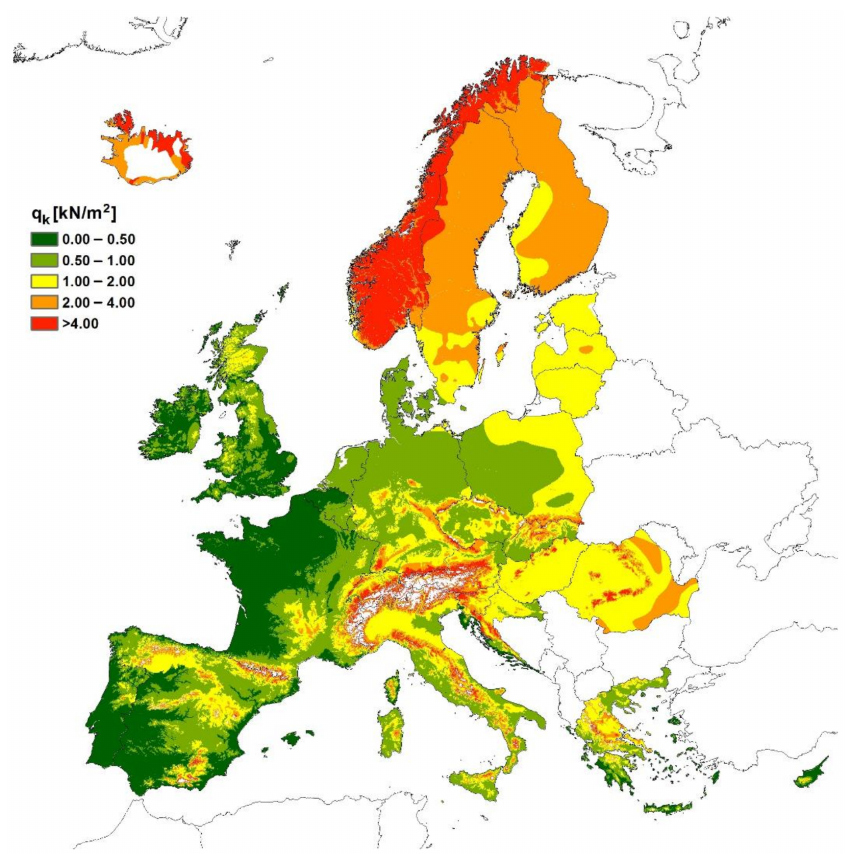
Figure 2. European ground snow load map resulting from European Committee for Standardization (CEN) National Annexes to EN1991-1-3:2003. Table 1. Coefficient of variations of the annual maxima of ground snow load ( COV g ) in Europe [15]. Altitude a Climatic Region